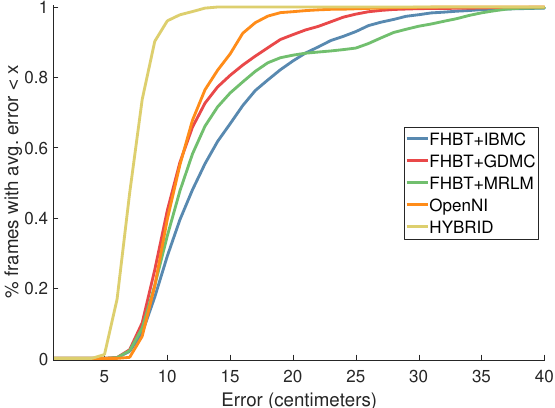
Figure 9. Average error and standard deviation in centimeters of FHBT extended with each of the presented matrix completion/recovery techniques compared to OpenNI and HYBRID, using the same dataset as in [7].